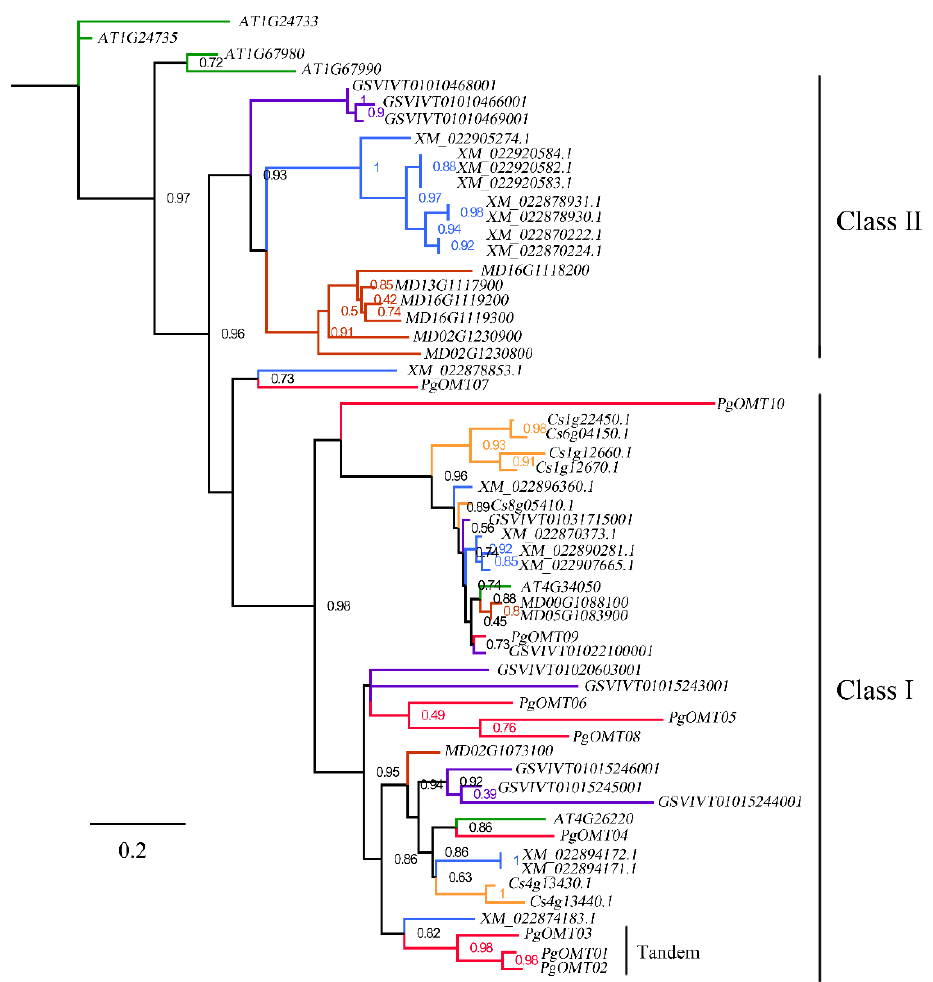
Figure 1. OMT ( O -methyltransferases) gene family phylogenetic tree of 6 species including pomegranate, A. thaliana , V. vinifera , M. domestica , C. sinensis and D. zibethinus presented by various branch colors. A total of 58 sequences were aligned with MAFFT (a multiple sequence alignment program) and the phylogenetic tree was contrasted using JTT (Jones-Taylor-Thornton) model. According to the phylogenetic relationship, 58 OMTs were divided into Class I (AOMT (anthocyanin O -methyltransferases) group) and Class II (OMT group). Node values beside branches were bootstrap-supported values generated from 1000 replicates. Pg: pomegranate; AT: A. thaliana ; Cs: C. sinensis ; GSVIVT: V. vinifera ; MD: M. domestica ;